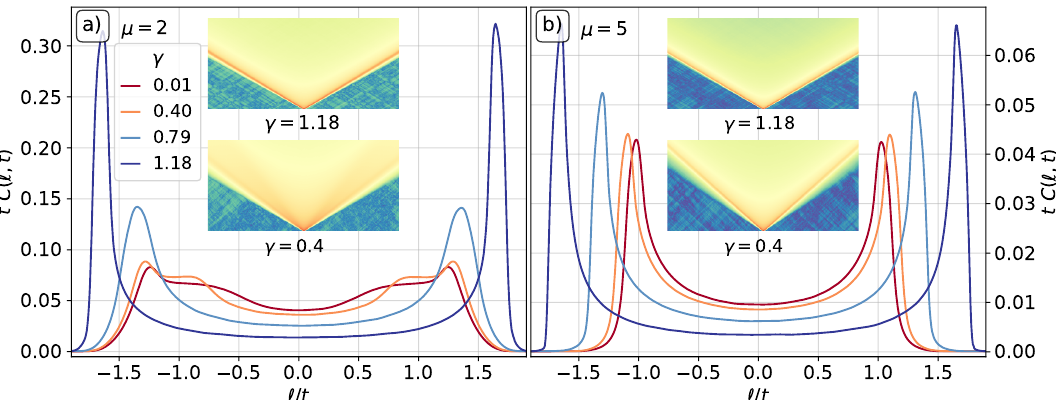
Figure 9: Rescaled ballistic stationary profiles of the dynamical structure factor t C ( (cid:96) , t ) for (a) µ = 2 and (b) µ = 5, with the corresponding space-time depen- dence C ( (cid:96) , t ) (inset plots). Simulation parameters: τ = 1, L = 2 12 , averaged over 10 5 initial